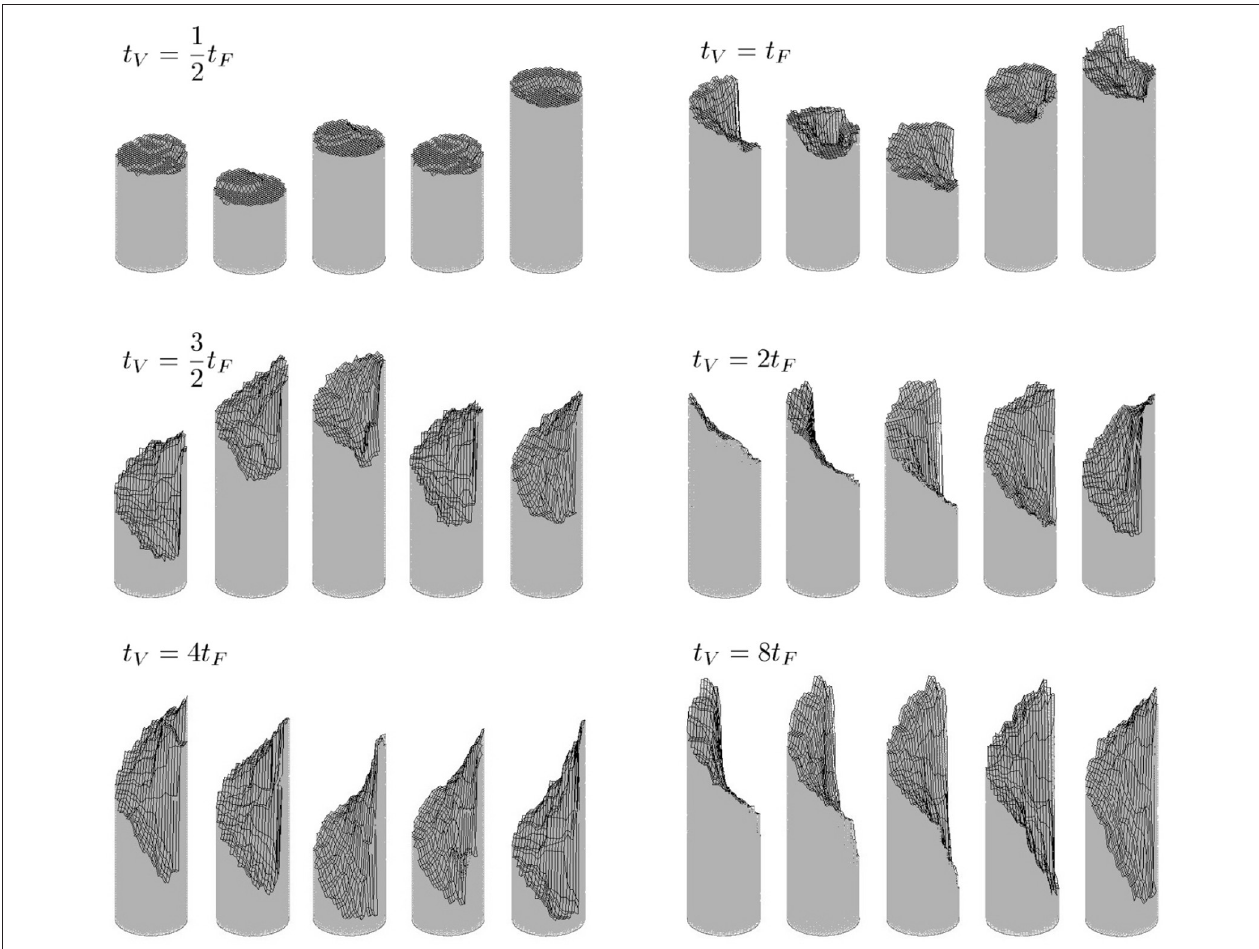
FIGURE 18 | Cylindrical shafts with diameter d = 25 and height H = 101 broken by the application of torque, using different strength levels in the randomly generated breaking thresholds. The disorder used in all cases is D = 0.4, using Equation (21). At top left five different samples are shown having tensile thresholds twice as strong as those in shear. At top right tensile and shear thresholds are equal, also showing five different samples. At left in the middle row are shown five different samples with shear thresholds one and a half times as strong as the tensile thresholds, these samples have been rotated so as to display more or less the same view. At right in the middle row shear thresholds are twice as strong as tensile thresholds. A typical sample is shown from five slightly different angles in this case. At bottom left are shown five samples with shear thresholds four times stronger than tensile thresholds, these have been rotated to display more or less the same view. Finally, at bottom right a typical sample where shear thresholds are eight times stronger than tensile thresholds is included, this has been shown from five slightly different angles. In all cases the fracture criterion used is Equation